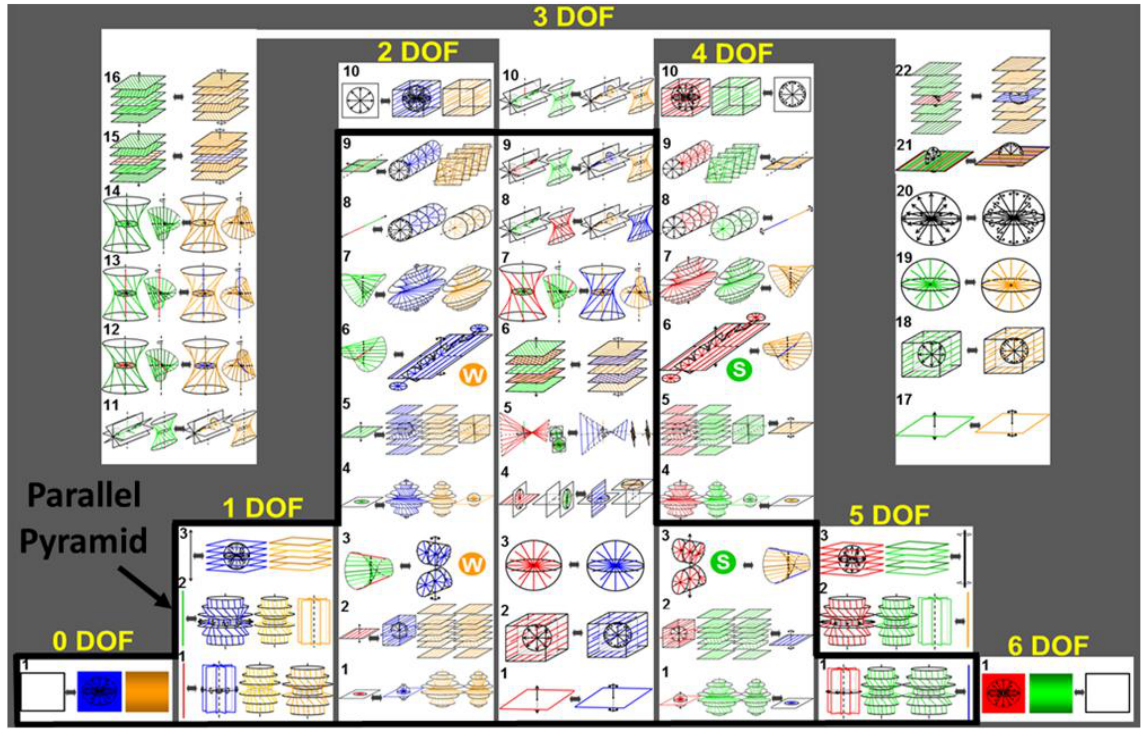
Figure 5. Comprehensive library of freedom and constraint spaces.